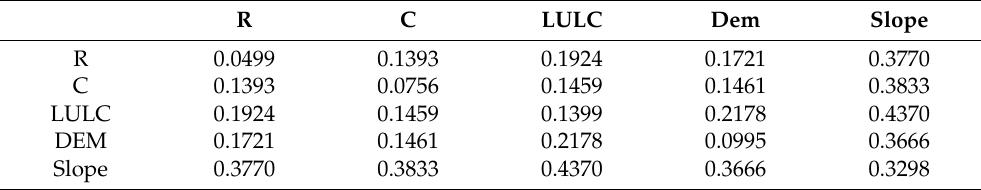
Table 10. The q value of the interaction of each factor on SE in the QLB. R C LULC Dem